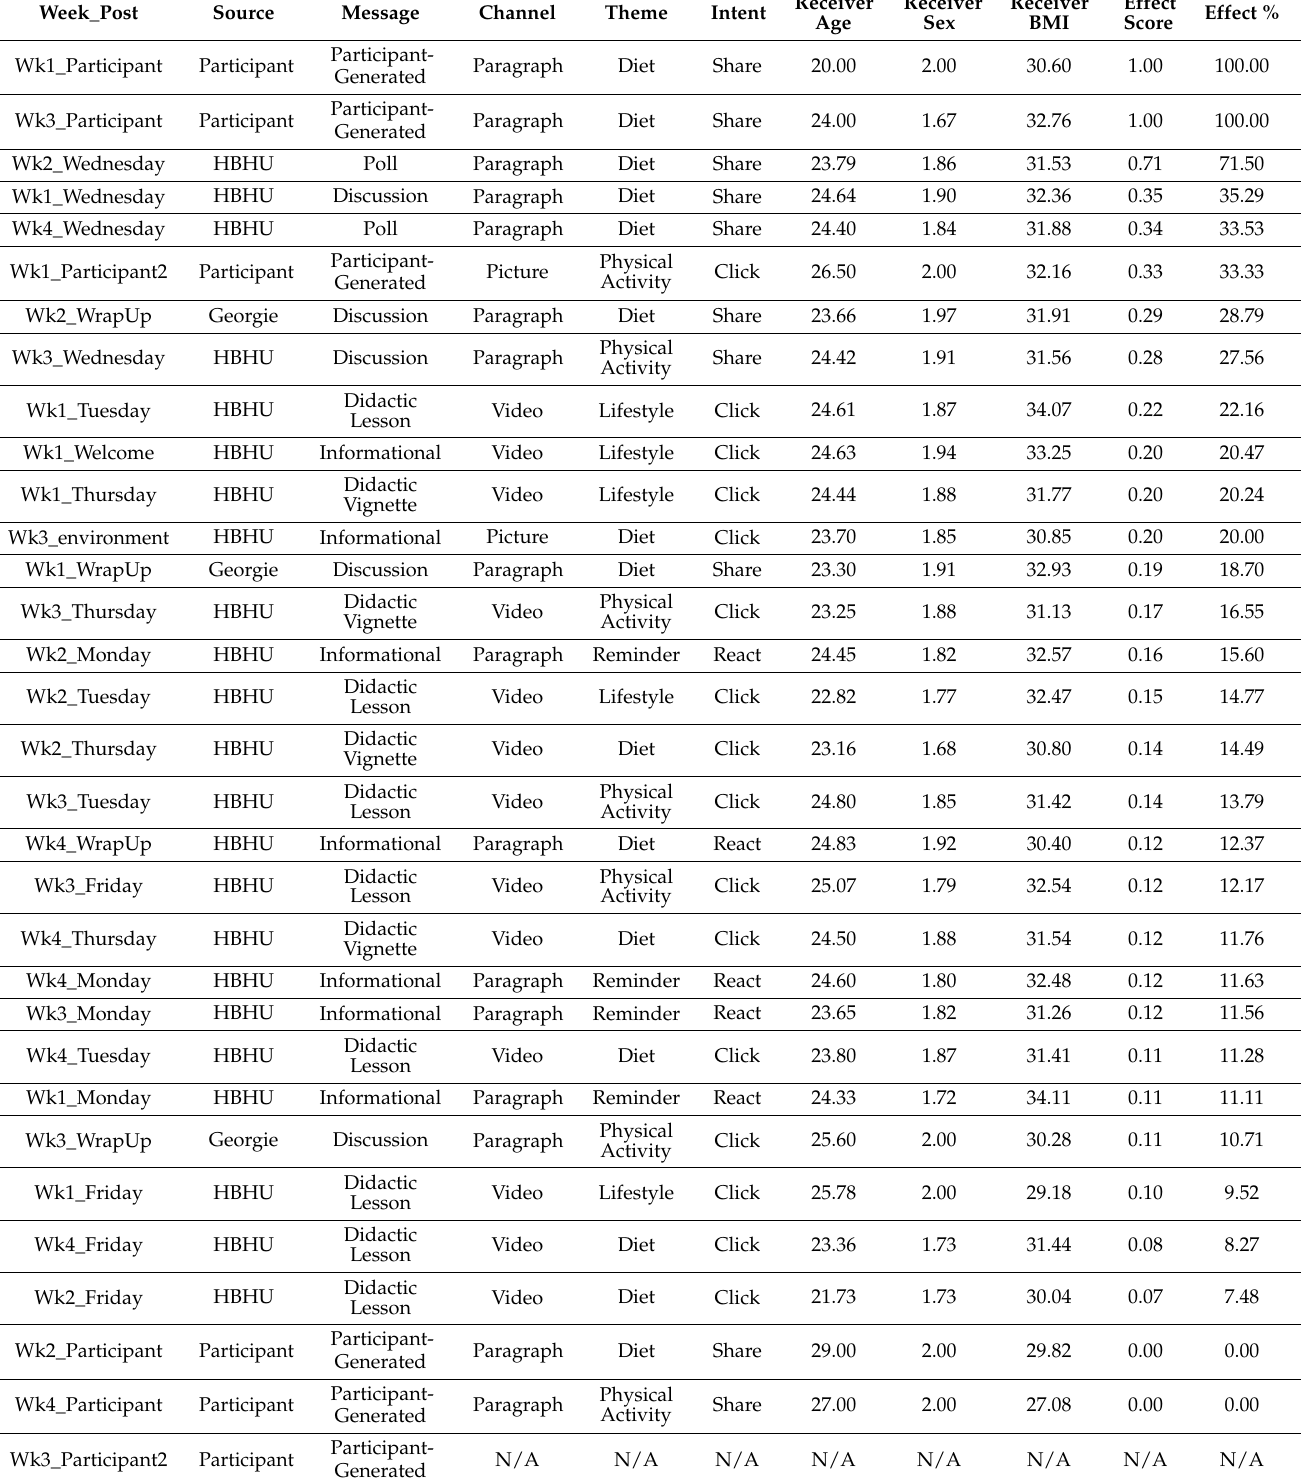
Table 2. Coded date for all posts (n =